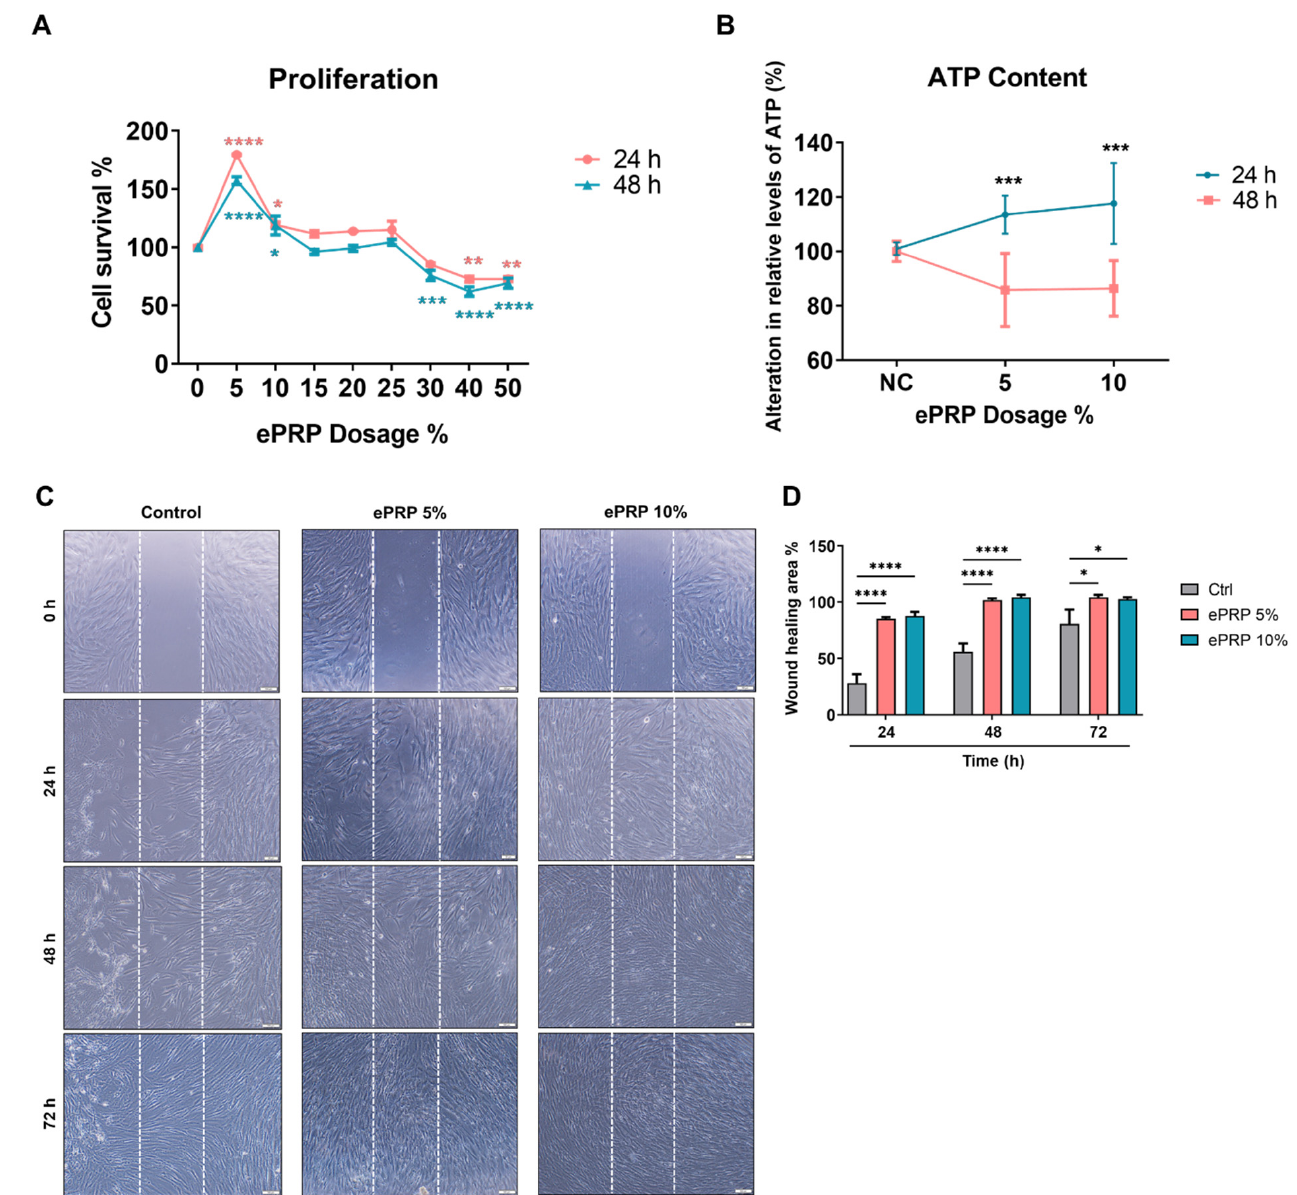
Figure 2. ePRP promotes wound healing ability in fibroblasts. ( A ) Fibroblasts treated for 24 and 48 h with ePRP. The relative viability rate was determined using the CCK-8 test, and all treatment groups were compared to the vehicle control group (100%). The data is shown as mean ± SEM (N = 2, N denotes the number of independent experiments performed). ( B ) Fibroblast ATP levels after treatment with 5% and 10% ePRP for 24 and 48 h. At 24 h, there was a considerable rise in ATP, which was dosage-dependent. The data are shown as mean ± SEM (N = 2). ( C ) Wound healing migration experiments were performed in fibroblasts at 0, 24, 48, and 72 h in 5% and 10% ePRP pre-treated cells, with untreated cells serving as a control. The area covered by the cells at 0, 24, 48, and 72 h after wounding is depicted in illustrative microscope images. The scale bars indicate a distance of 100 μ m. ( D ) The statistical outcomes of migration area percentage of independently repeated experiments as mean ± SEM (N = 3) were shown in bar graphs. The two-way ANOVA with Sidak’s multiple comparisons test is used to evaluate all ePRP treatments statistically (* p < 0.05, ** p < 0.01, *** p < 0.001, **** p < 0.0001).